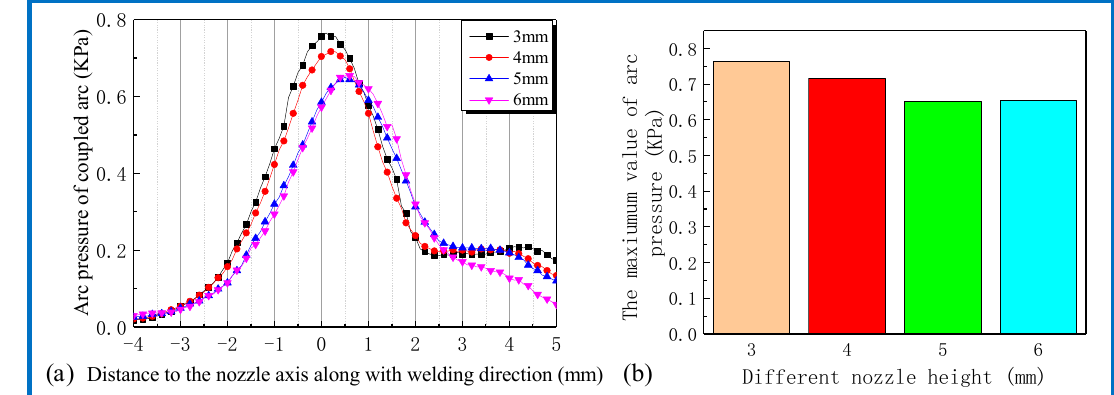
Figure 11. Coupled arc pressure with different nozzle height. ( a ) Coupled arc pressure along with welding direction. ( b ) Max value of coupled arc pressure.